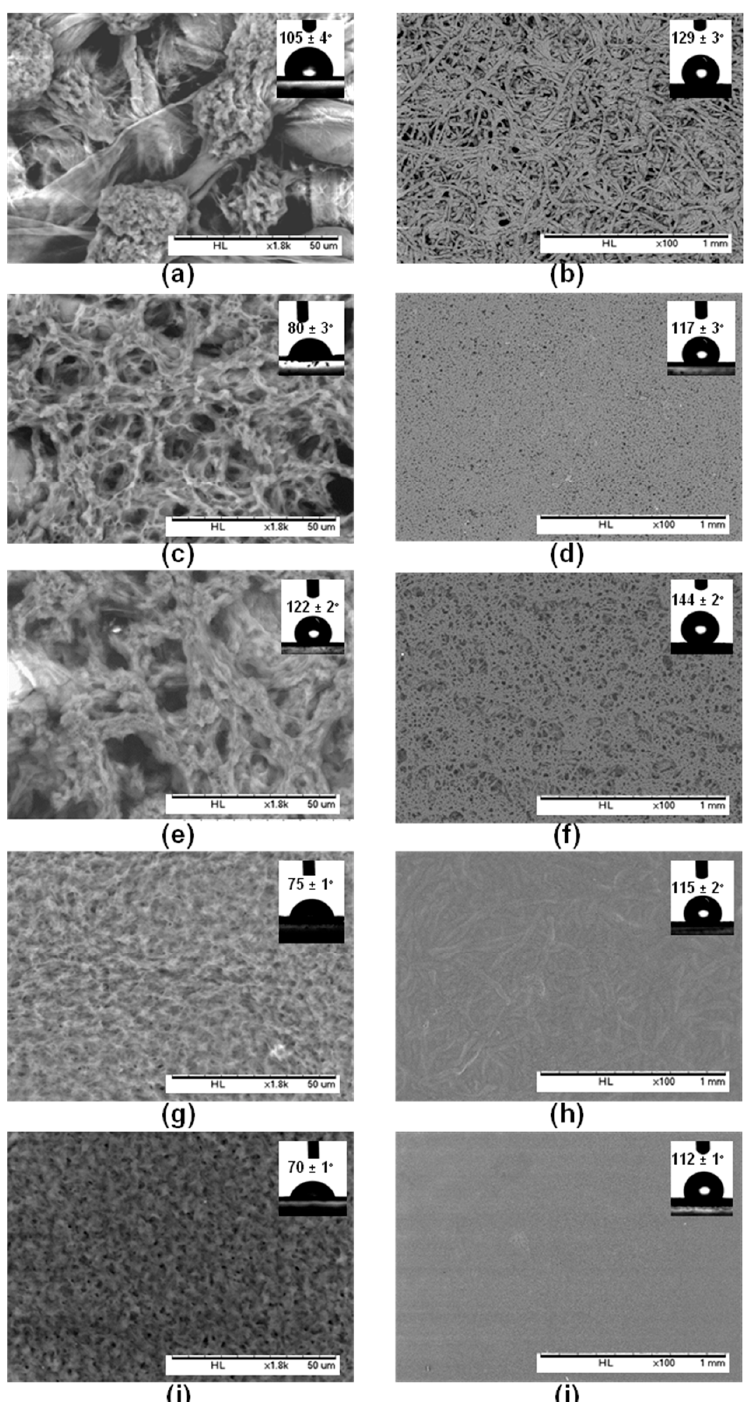
Figure 5. Scanning electron microscopy for PHB-MP-coated papers from suspensions with different concentrations: ( a , b ) PHB-MP, with 8.5 w / v % of PHB and 7.4 v / v % non-solvent; ( c , d ) PHB-MP, with 17.0 w / v % of PHB and 7.4 v / v % non-solvent; ( e , f ) PHB-MP, with 17.0 w / v % of PHB and 14.8 v / v % non-solvent; ( g , h ) PHB-MP, with 17.0 w / v % of PHB and 23.1 v / v % non-solvent; ( i , j ) neat PHB, with 8.5 w / v % of PHB without non-solvent. The figures ( a , c , e , g , i ) are magnified images with a scale of 50 µ m; insets are water contact angles on coated papers without additional wax coating. The figures in ( b , d , f , h , j ) are images of a larger area with a scale of 1 mm; insets are water contact angles after the application of an additional wax layer over the coated